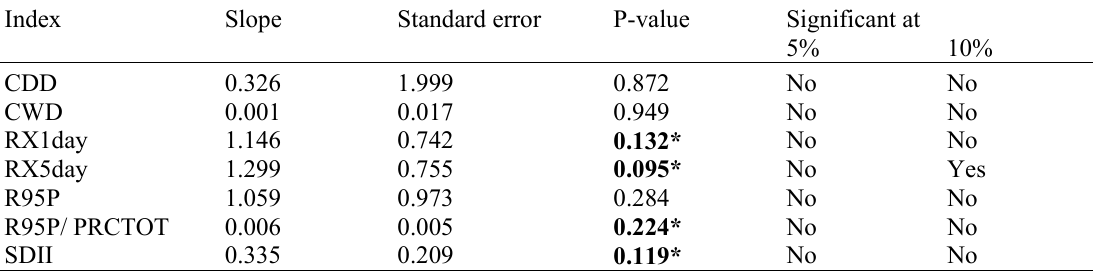
Table 2 test statistics of precipitation indices.